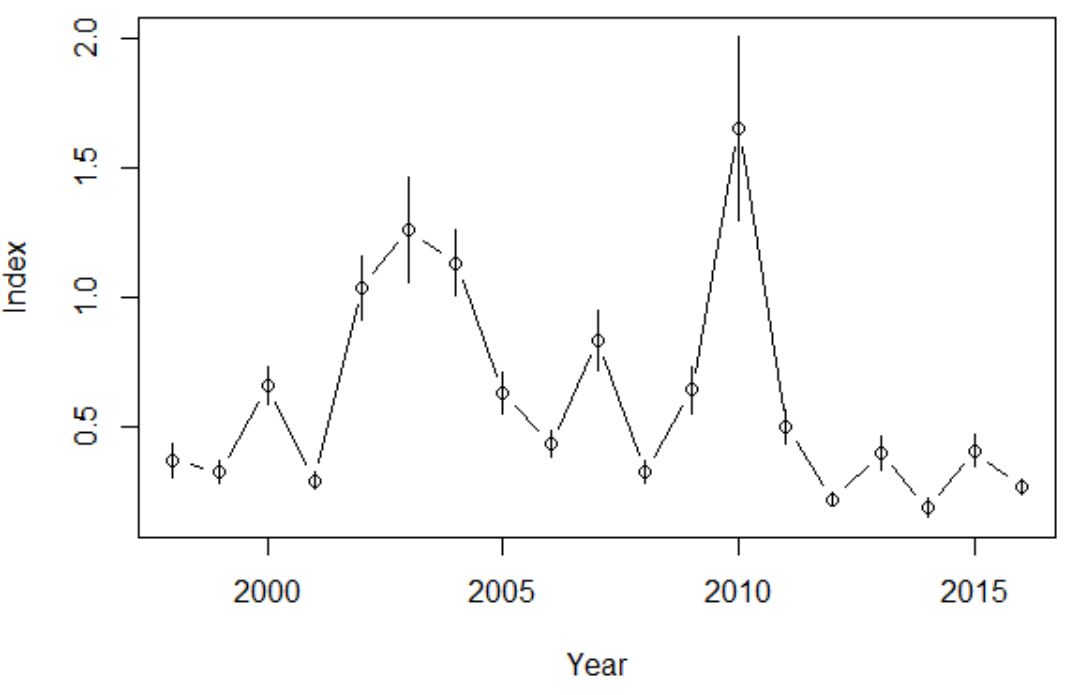
Figure 29. Index of relative abundance of horseshoe crab (delta mean catch per tow) developed from the fall portion of Rhode Island’s Coastal Trawl Survey Monthly Segment with 95% confidence